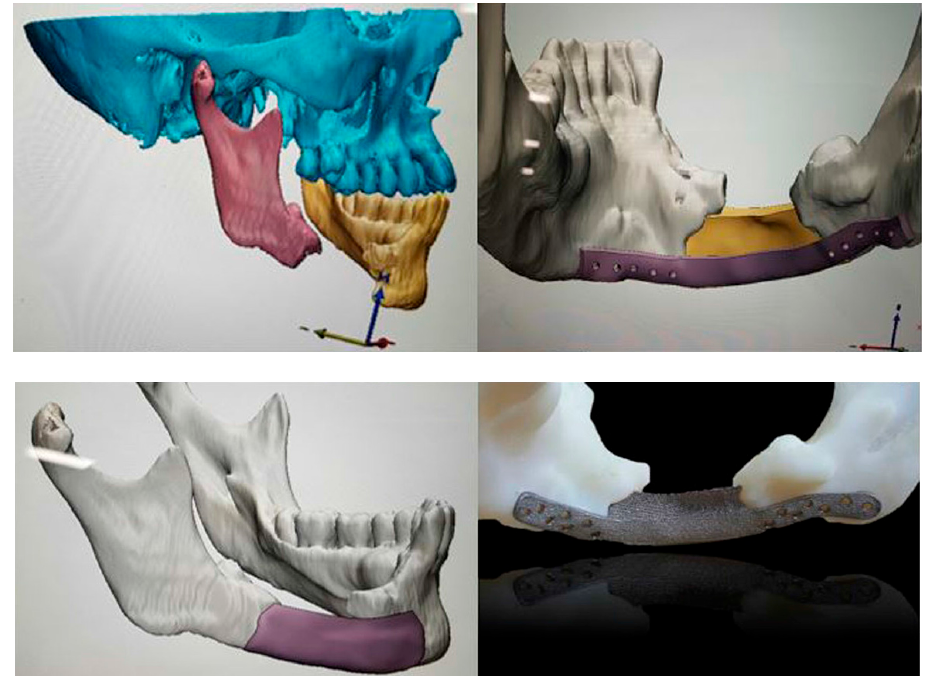
Figure 2. The design and fabrication of polyetheretherketone patient-specific implants using CAD/CAM system for jaw reconstruction. Reproduced from [31] with permission of Springer under the terms